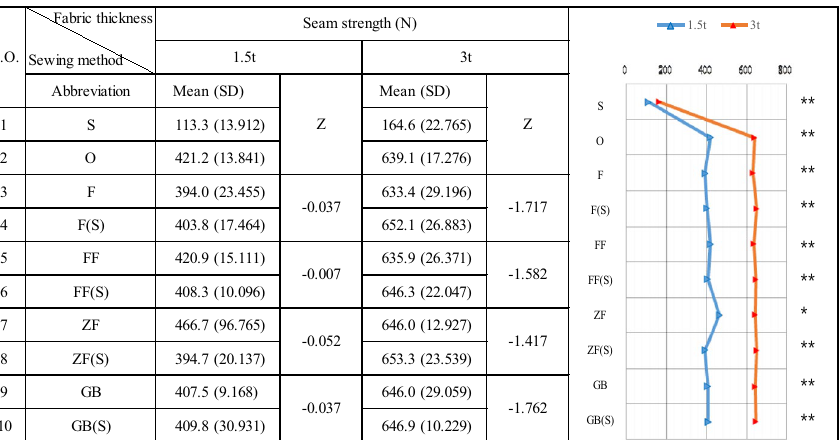
Table 4 Test results of Wilcoxon signed rank t-test for seam